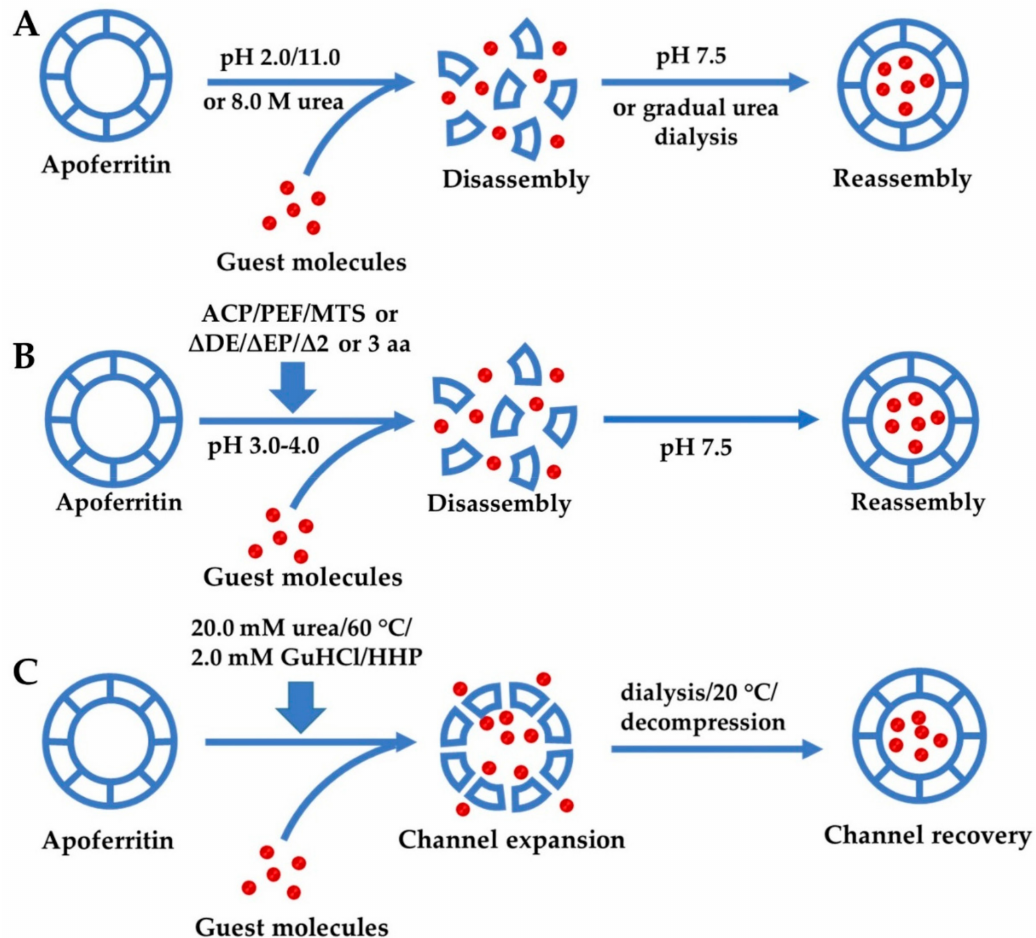
Figure 4. Schematics for the fabrication process of guest molecules encapsulated within the ferritin cavity by different mechanisms: ( A ) self-assembly of ferritin controlled by different chemicals; ( B ) regulation of ferritin self-assembly by physical methods or genetic modification under relatively mild conditions; ( C ) expansion of ferritin channels by different methods. ACP, atmospheric cold plasma; PEF, pulsed electric field; MTS, manothermosonication; EP, extension peptide; HHP, high hydrostatic